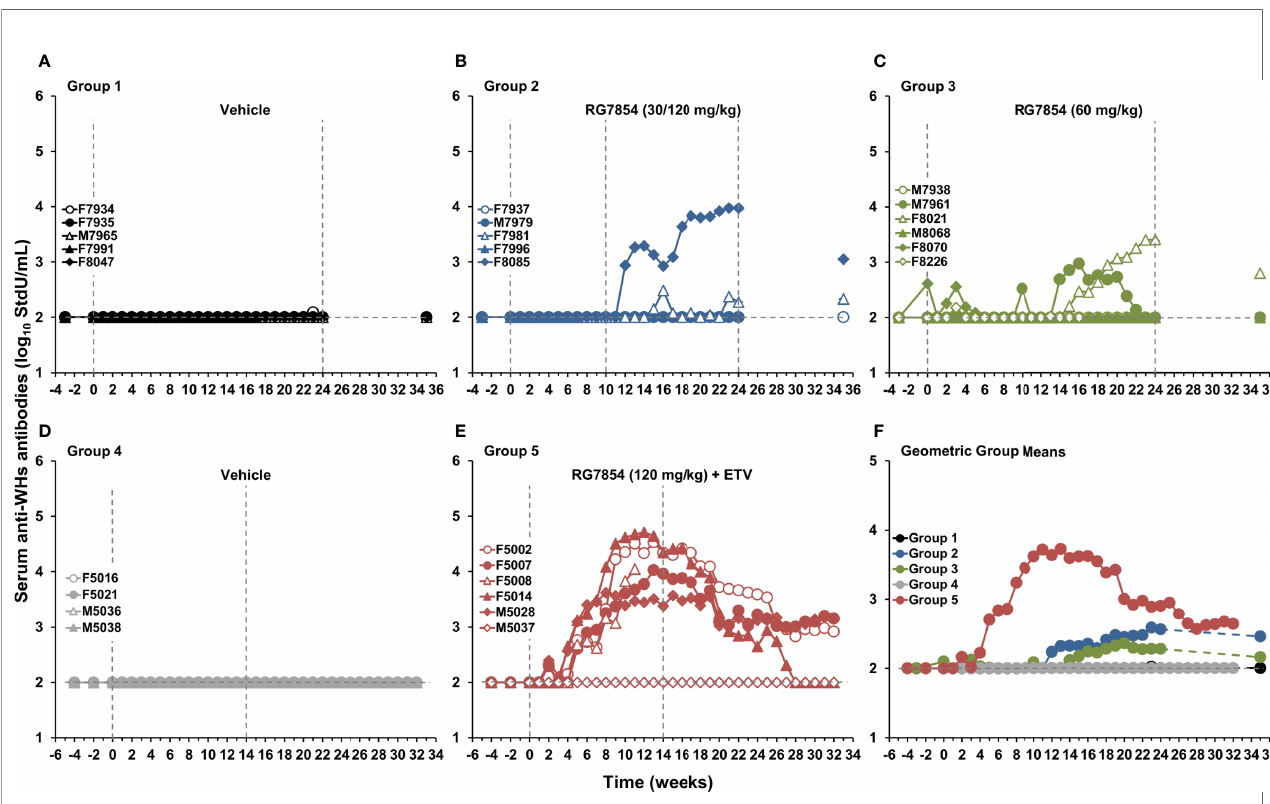
FIGURE 4 | Effect of RG7854 treatment, alone and together with ETV, on the elicitation of serum antibodies to WHsAg. Kinetics of anti-WHs antibody titer in individual woodchucks administered (A) placebo or RG7854 at doses of (B) 30/120 mg/kg or (C) 60 mg/kg in the monotreatment study and (D) placebo or (E) RG7854 at a dose of 120 mg/kg plus ETV in the combination treatment study. (F) Geometric group mean anti-WHs antibody titers. The horizontal dotted lines indicate the detection limit for anti-WHs antibodies by quantitative enzyme immunoassay (i.e., 100 StdU/mL). The geometric mean anti-WHs antibody titers in Group 2 and Group 3 were not signi fi cantly different to Group 1 ( P > 0.05) (Student ’ s t -test). Compared to Group 4, the geometric mean anti-WHs antibody titer in Group 5 was signi fi cantly increased during weeks 5-27 ( P < 0.05). StdU, standard